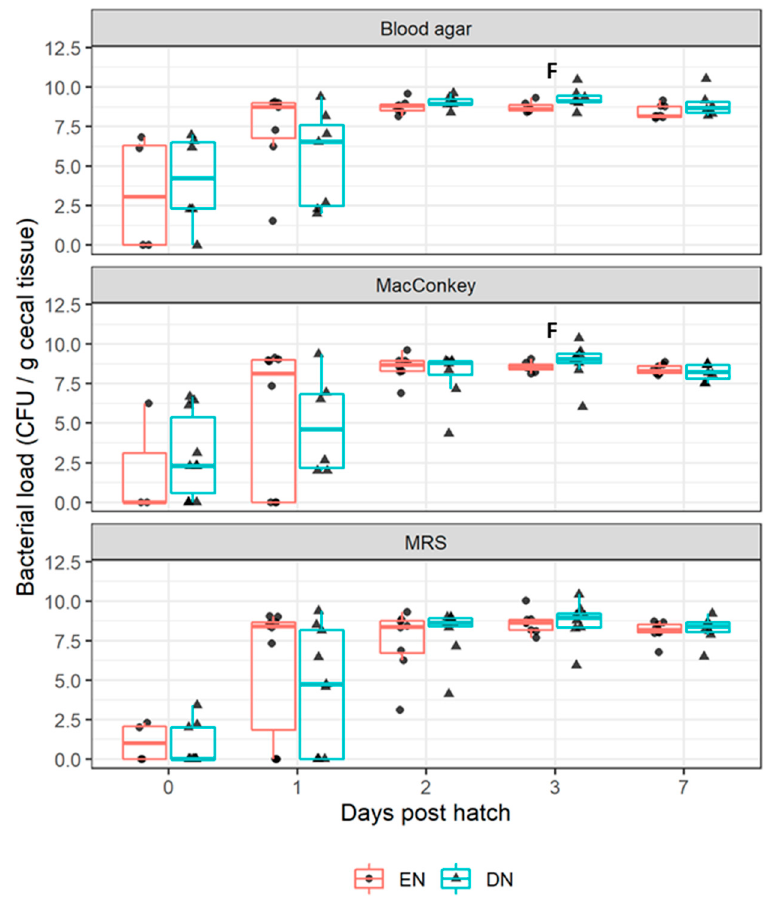
Figure 2. Number of aerobic cultured bacteria on 3 different growth media (blood, MacConkey, and De Man, Rogosa, and Sharpe (MRS) agar) expressed in log 10 CFU (colony forming units) per gram of cecal tissue, during the first week post-hatch, in the cecum of broiler chickens receiving delayed (DN) or early nutrition (EN) in experiment II. Colony forming units from individual broiler (dots and triangles) are summarized by boxplots. Tendencies indicating age differences between feeding groups within age are indicated by F ( p ≤ 0.10). The number of replicate broilers varied between 3–10 per age and feeding group. The horizontal line within each boxplot represents the median and the whiskers, extended to the 1.5 × interquartile range.